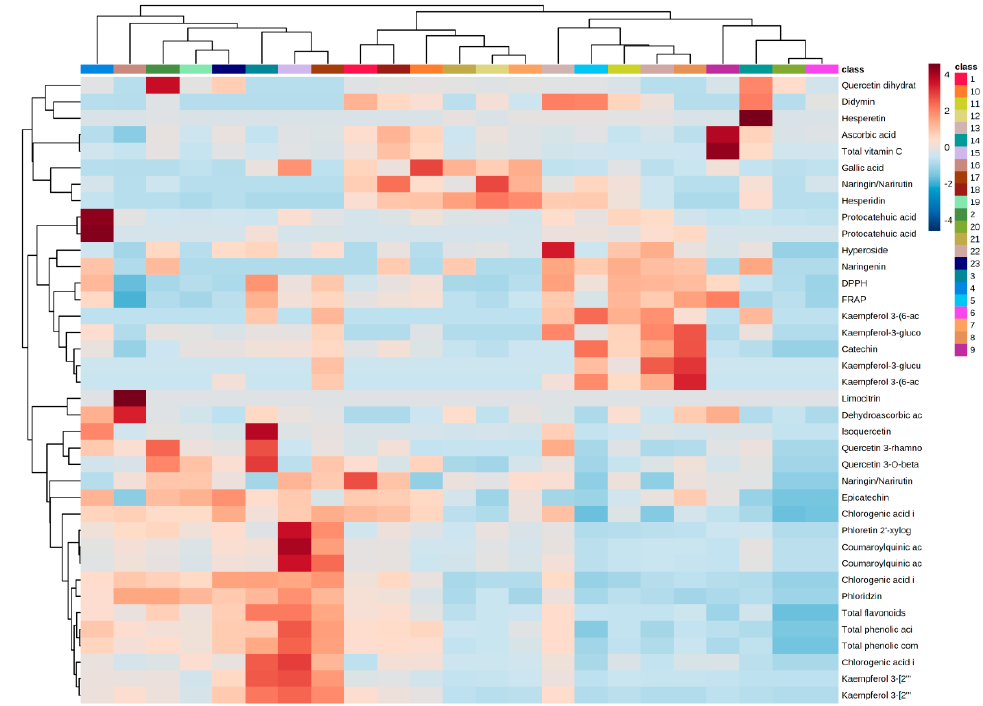
Figure 3. Clustering heatmap of the smoothies for the measured